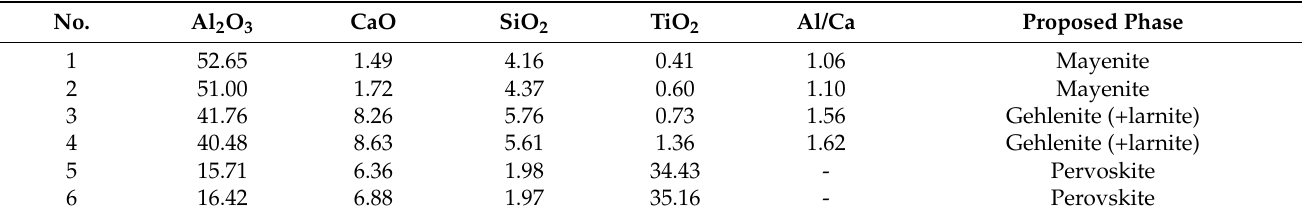
Table 3. Percentage mass quantification of selected elements in the slag by